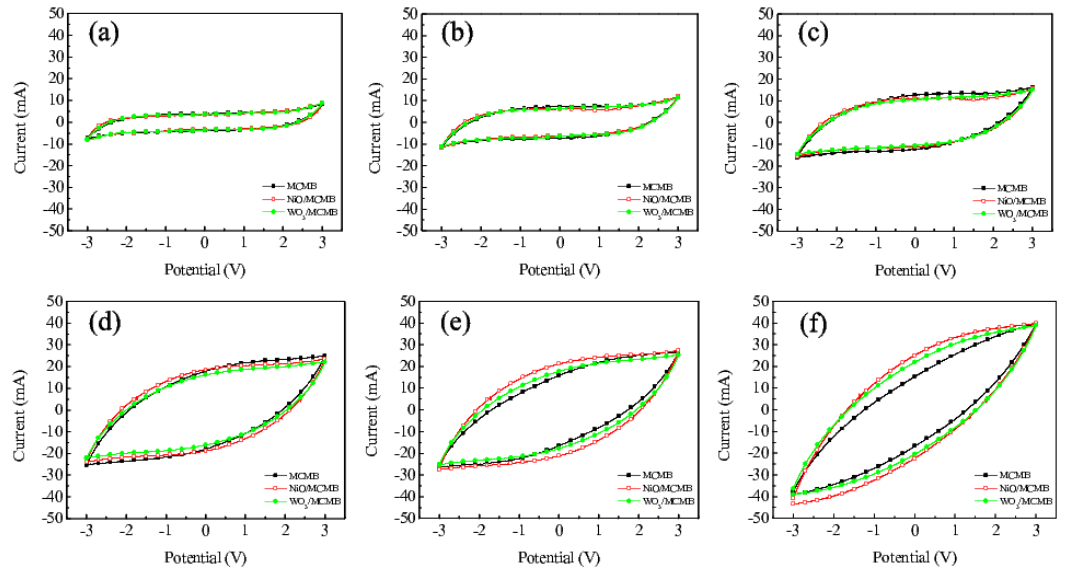
Figure 5. CVs of the carbon electrodes and the composite electrodes in 1M Et 4 NBF 4 solution at various scan rates: ( a ) 25 mV/s ( b ) 50 mV/s ( c ) 100 mV/s ( d ) 200 mV/s ( e ) 250 mV/s ( f ) 500 mV/s.